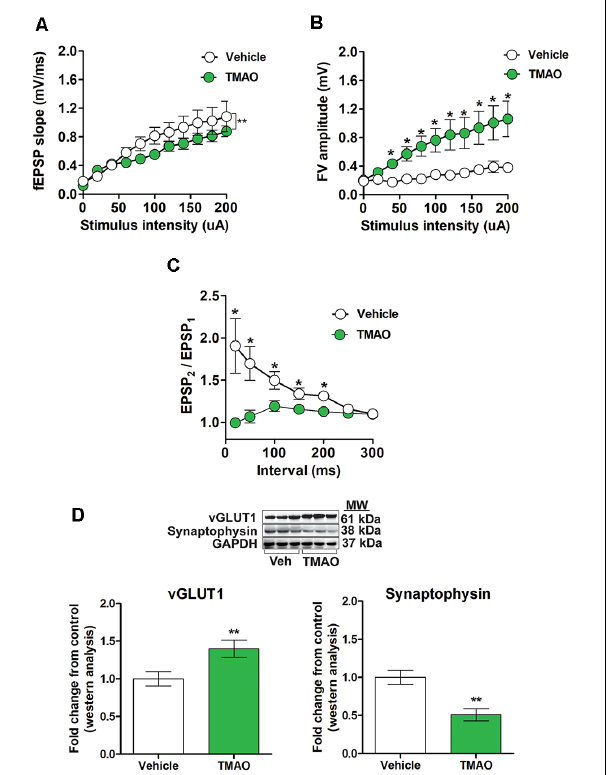
FIGURE 3 | TMAO treated slices exhibits alterations in basal synaptic transmission and paired-pulse facilitation (PPF). For (A–C) , hippocampal slices were incubated in ACSF with either 0.03% DMSO (vehicle) or TMAO (50 µ M) for 4 h before recording. (A) The input-output curve of the fEPSP slope measured at increasing stimulus intensities. (B) The input-output curve of FV amplitude measured at increasing stimulus intensities. (C) Change in the ratio of second stimulus fEPSP (EPSP2) to the first stimulus fEPSP (EPSP1) slope plotted as a function of interstimulus interval. (D) Representative western blot showing vGLUT1 and synaptophysin relative densities normalized to GAPDH in slices treated with either vehicle or TMAO (50 µ M); for panels (A–C) n = 5–6 slices from four mice per group; for (D) n = 3 mice per group; for panels (A–C) planned pairwise comparisons were performed for individual data point analysis for a vehicle vs. TMAO-treated slices. Symbols/bars represent mean ± SEM; *indicates significant difference between vehicle vs. TMAO-treated slices, * p < 0.05, ** p < 0.001. p = 0.0093, Figure 3D ) and a decrease in synaptophysin density ( t (4) = 6.929, p = 0.0023, Figure 3D ) in TMAO treated